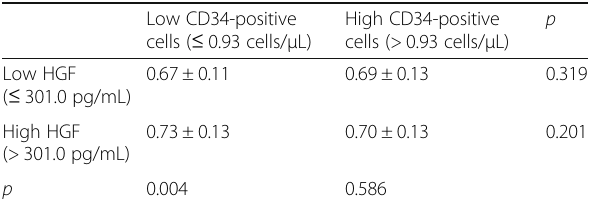
Table 4 Mean values of carotid intima-media thickness (CIMT) in terms of hepatocyte growth factor (HGF) levels and CD34-positive cell